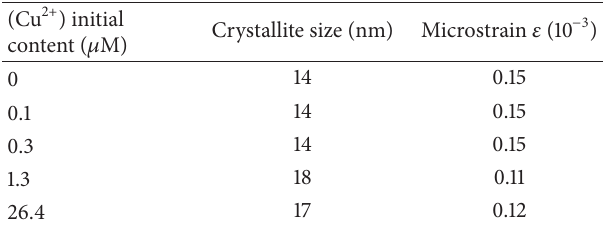
Table 1: Crystallite size and microstrain estimated from XRD studies for all ZnO films.